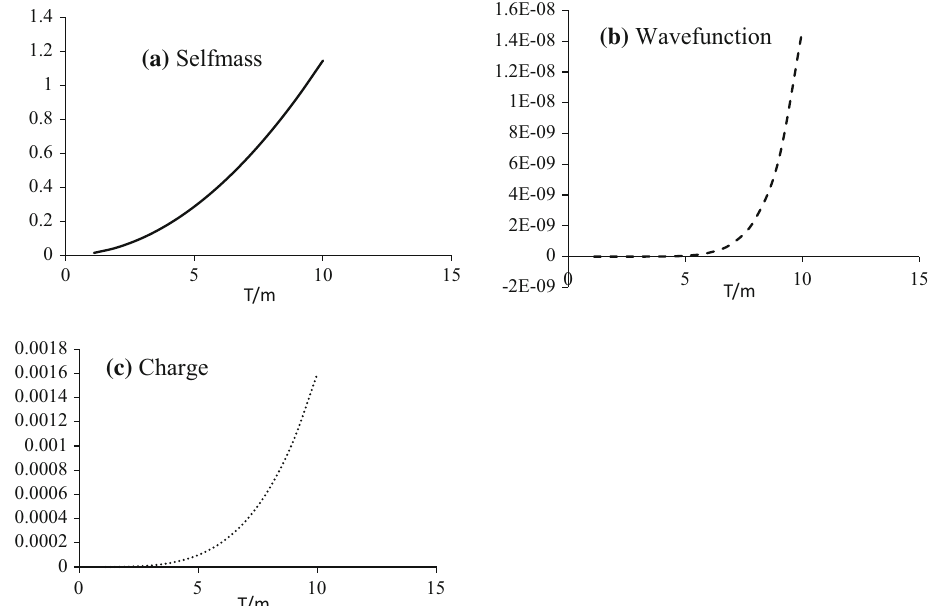
Fig. 2 The properties of the electrons as a function of temperature (in units of m). The thermal corrections to a electron mass; b wave function; and c charge small even at T > m . However, the charge of the electron is not affected by the background at low temperatures ( T < m ) because massless photons do not interact among themselves.